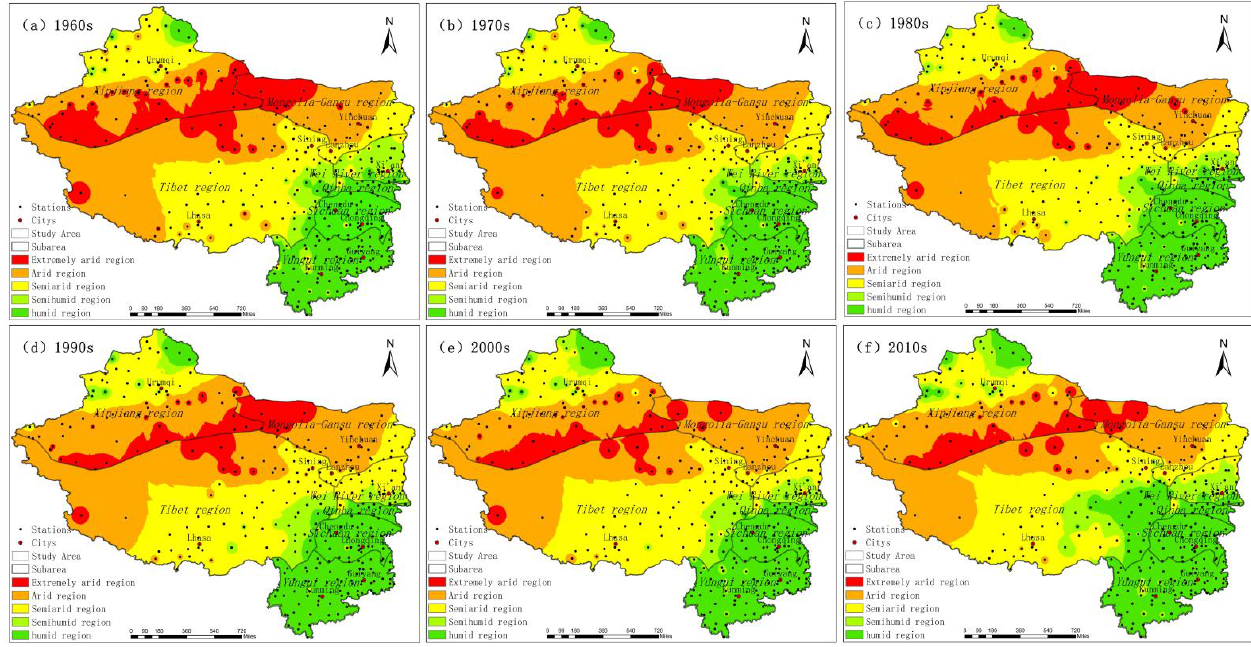
Figure 3. Decadal distribution and variation of dry and wet areas in western China. Table 1. Area statistics of dry and wet zones in the study area.